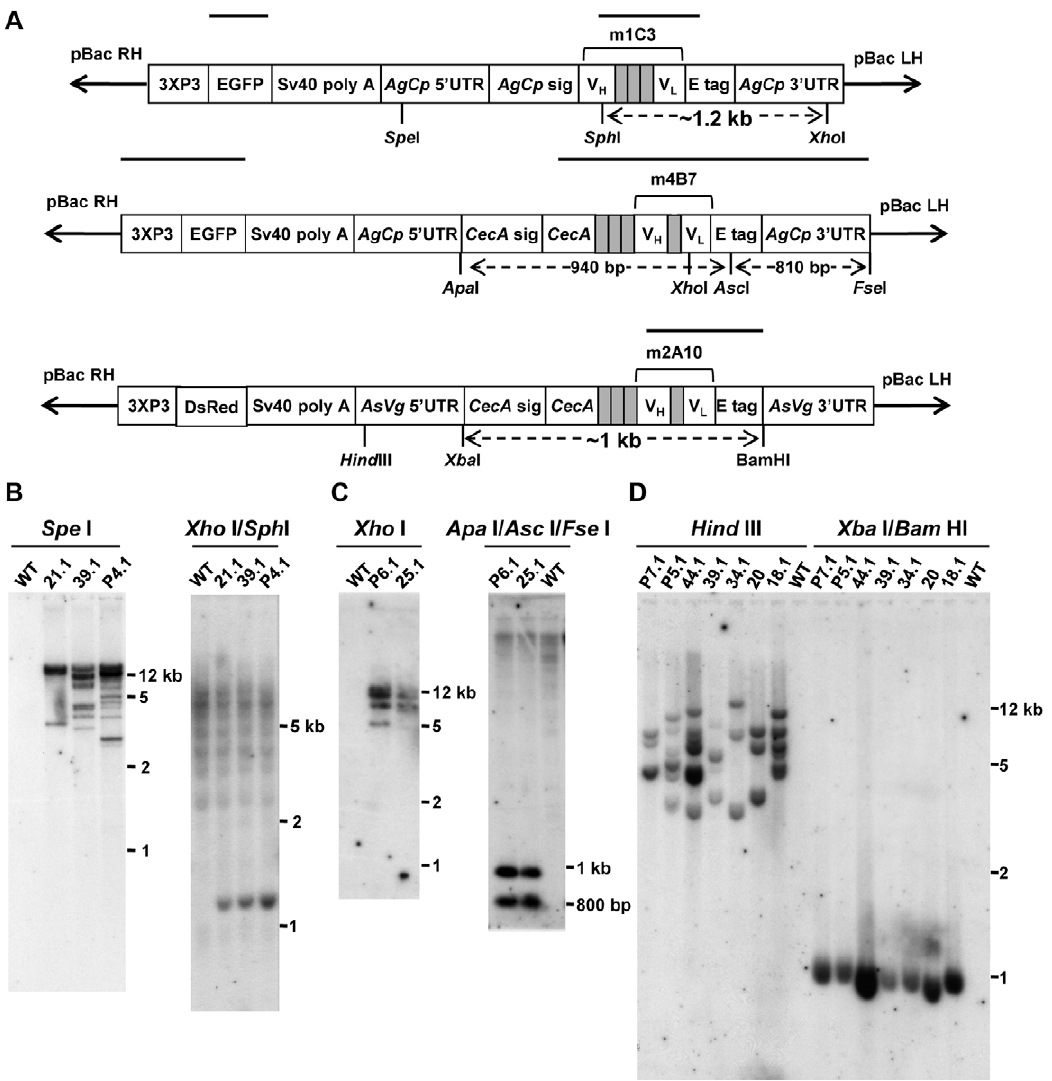
Figure 2. Southern blot analyses of m1C3, m4B7, and m2A10 transgenic lines. (A) Schematic representations of the single-chain antibody (scFv) transformation constructs. The scFv heavy (V H ) and light (V L ) variable region genes in the m1C3 construct are joined by sequence encoding a long polypeptide linker (multiple grey boxes). The sequence encoding the V H is joined to the An. gambiae carboxypeptidase A signal sequence ( AgCp sig). In the m4B7 and m2A10 constructs, the An. gambiae Cecropin A gene ( CecA ), including signal sequences ( CecA sig), is joined by sequence encoding a long polypeptide linker to the scFv V H and V L genes. The V H and V L genes are joined by a short polypeptide linker (single grey box). All three scFvs are joined to an epitope tag (E tag). The CecA-m2A10 effector gene is flanked by An. stephensi vitellogenin 1 regulatory sequences ( AsVg 5 9 UTR, 3 9 UTR), while the m1C3 and CecA-m4B7 genes are flanked by AgCP A regulatory sequences ( AgCp 5 9 UTR, 3 9 UTR). A transformation marker (EGFP or DsRed) joined to the Pax3 (3xP3) promoter and the SV40 polyadenylation sequence also is contained between the piggyBac transposase arms (pBacLH, RH). Select restriction endonuclease sites present in the transgene are indicated in the diagram. Probes used to identify the integrated transgenes are indicated by horizontal bars above each schematic representation. (B) Genomic DNA from m1C3 and wild-type control females was digested and hybridized to either an EGFP probe (left) or an m1C3 probe (right). (C) Genomic DNA from m4B7 and wild-type control females was digested and hybridized to either an EGFP probe (left) or an m4B7/ AgCPA 3 9 UTR probe (right). (D) Genomic DNA from m2A10 and wild-type control females was digested and hybridized to an m2A10 probe. The restriction endonucleases used in each experiment are listed above the blot, and the identity of each transgenic line is listed above each lane. The locations of molecular weight markers are indicated in kilobase pairs